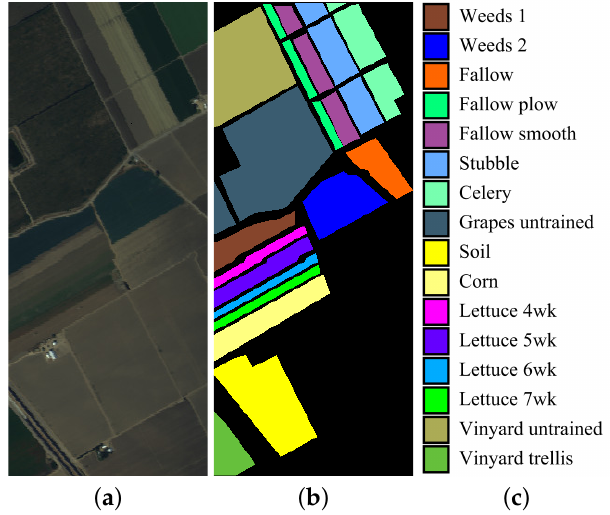
Figure 4. Salinas data set. ( a ) false-color composite; ( b , c ) ground truth data.